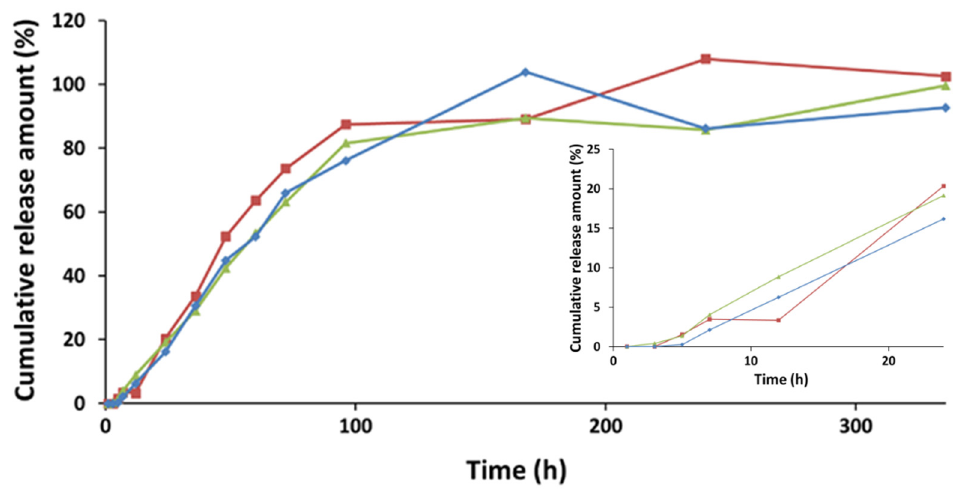
Figure 5. Curcumin release profile of LVM microemulsion (red), 0.3 wt.% sodium hyaluronate in LVM (blue), and 0.34 wt.% Chitosan in LVM (green) .